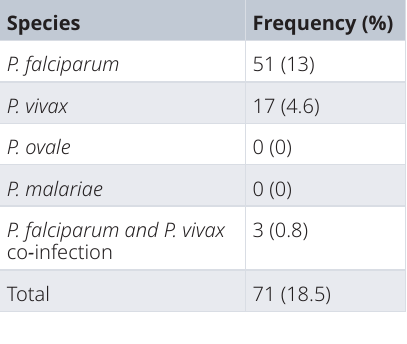
Table 2. Distribution of Plasmodium species in the study area.